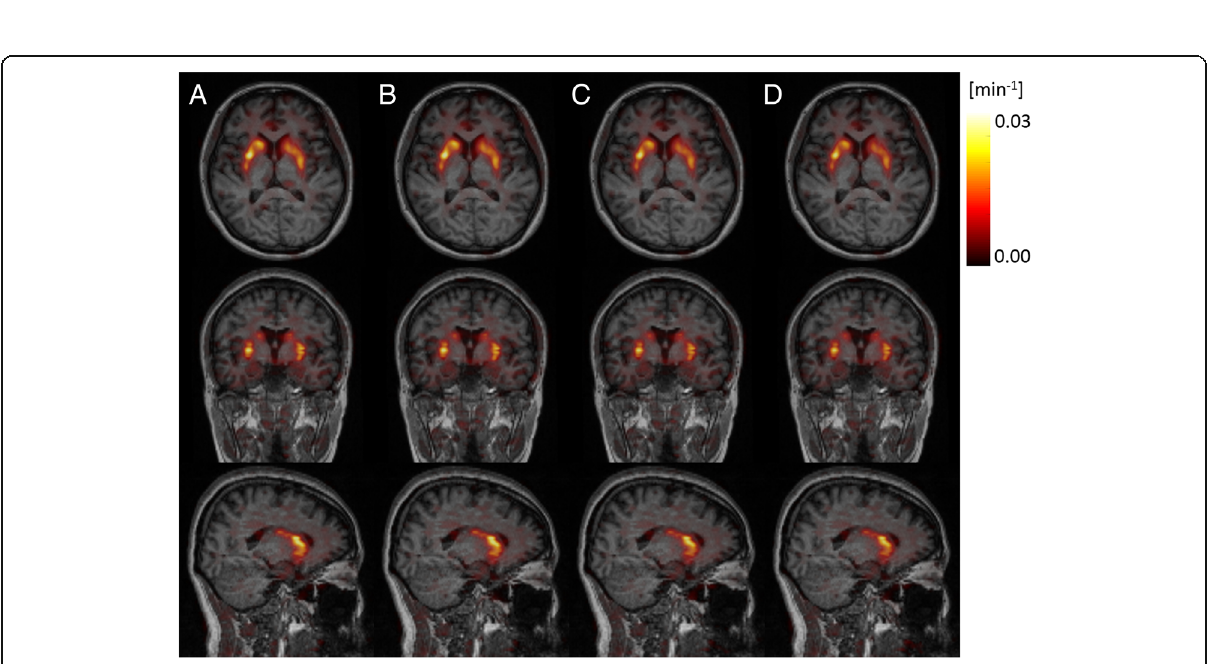
Fig. 5 Axial (top), coronal (middle), and sagittal (bottom) views of an exemplar Ki parametric maps using the μ -map DXN ( a ), the μ -ma pdUTE ( b ), the μ -map dUTE − R2 ( c ), and the pCT ( d ), obtained using the cerebellar cortex as reference